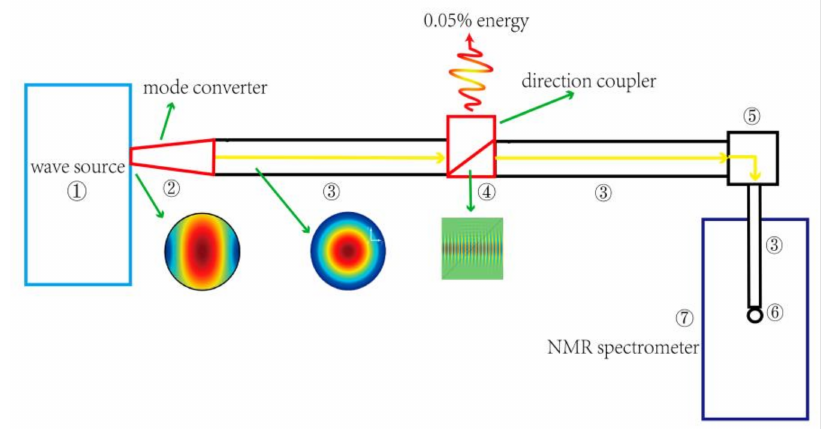
Figure 1. 330 GHz transmission line layout for DNP-NMR system. 1 (cid:13) THz wave source, 2 (cid:13) TE 11 - HE 11 mode converter, 3 (cid:13) circular corrugated waveguide, 4 (cid:13) direction coupler, 5 (cid:13) 90 ◦ miter bend, 6 (cid:13) sample, 7 (cid:13) NMR spectrometer.